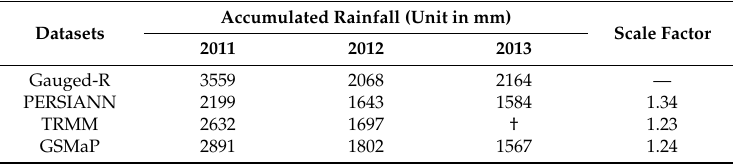
Table 3. Summation of yearly total amount and scale factors of the rainfall